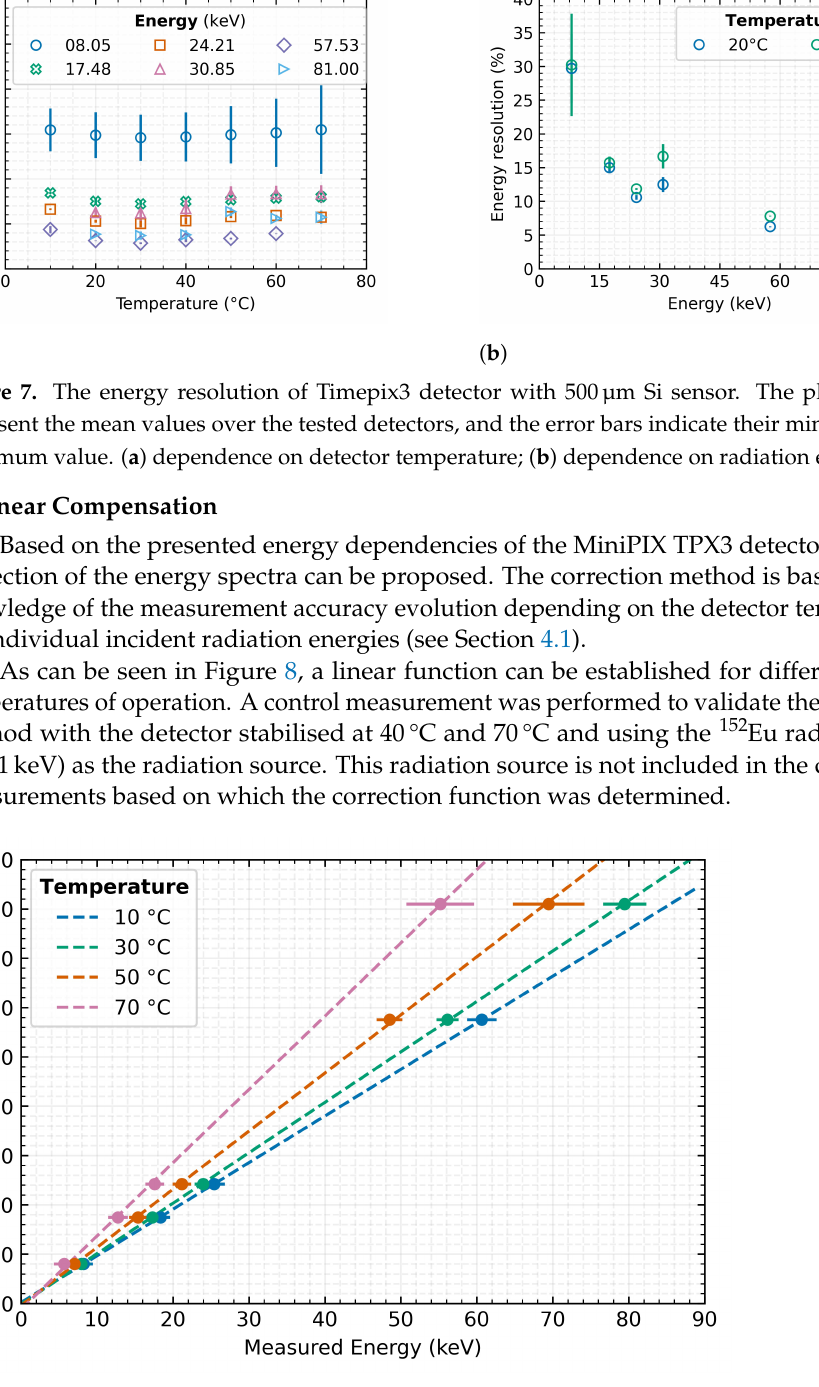
Figure 8. The correction functions for the global energy spectra of one of the tested detectors. Error bars represent the standard deviation of the measured value of the energy